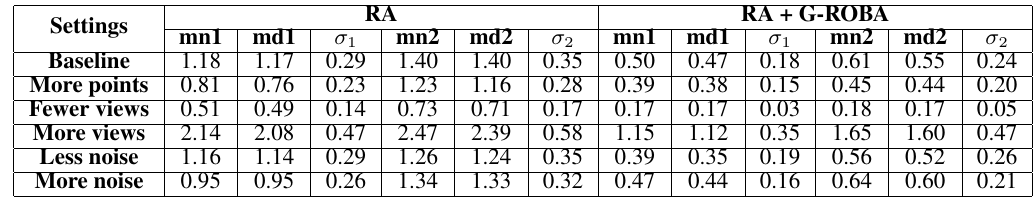
Table 2: Results of the block simulation. The metrics, mn/md/ σ /1/2: mean/median angular error (in degrees) after the L 1 / L 2 alignment, respectively. For all settings, the RA + G-ROBA improves the results of the RA. al., 2012). The vehicle was designed for high-resolution, geo- referenced imaging (Bryson et al., 2013). It includes 11,278